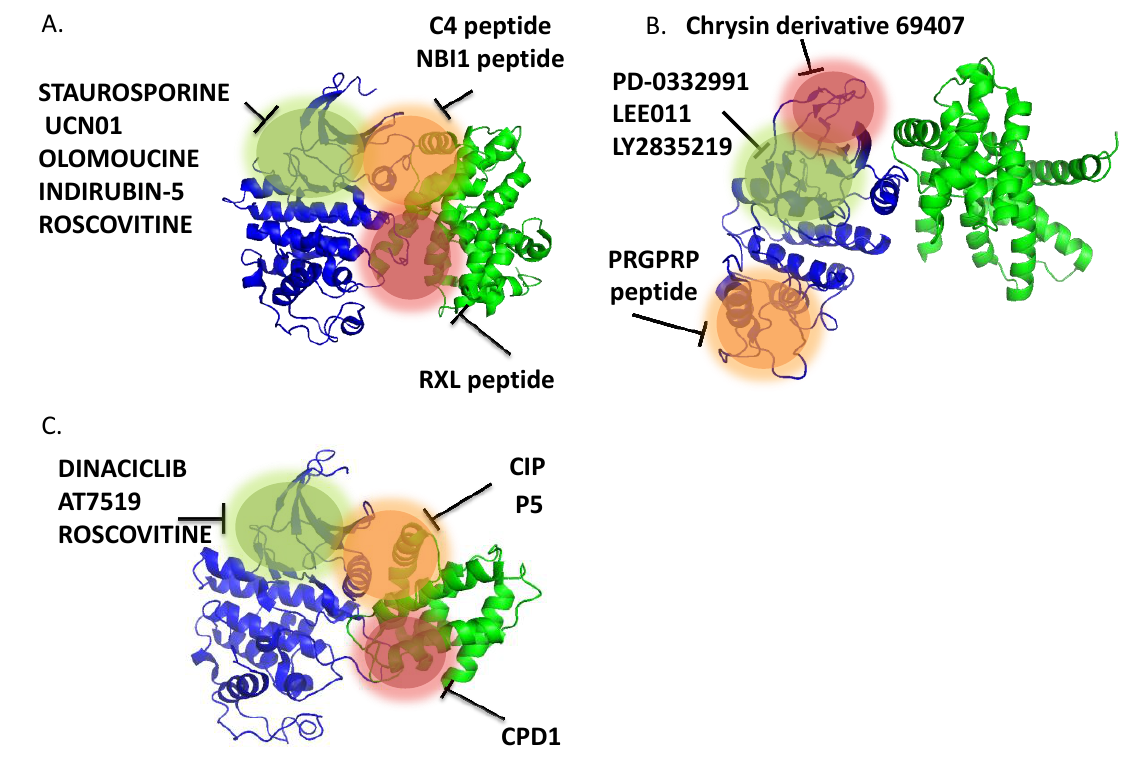
Figure 6. Inhibitors of CDK/Cyclins. ( A ) Structure and inhibitors of CDK2/Cyclin A PDB: 1QMZ; ( B ) Structure and inhibitors of CDK4/Cyclin D PDB 3G33 [CycD3]; ( C ) Structure and inhibitors of CDK5/p25.PDB